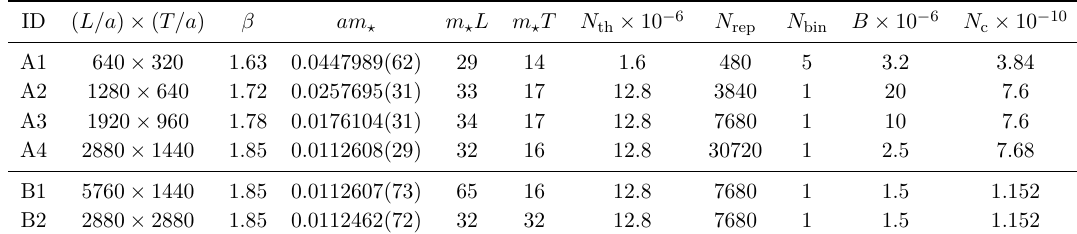
Table 2 . Details for the ensembles of field configurations generated for this work. The dimensionful scale m ? ’ m is defined in eq. (4.5). Ensembles A1-A4 enable the continuum limit at approximately fixed physical volume, while B1 and B2 are used to estimate finite size effects. Each ensemble consists of N rep independent identical replica, each of which is thermalized for N th cluster updates before N bin measurements are taken by averaging over B subsequent updates. This results in a total number of measurement cluster updates N c for each ensemble. Only two digits are given for m ? L and m ? T